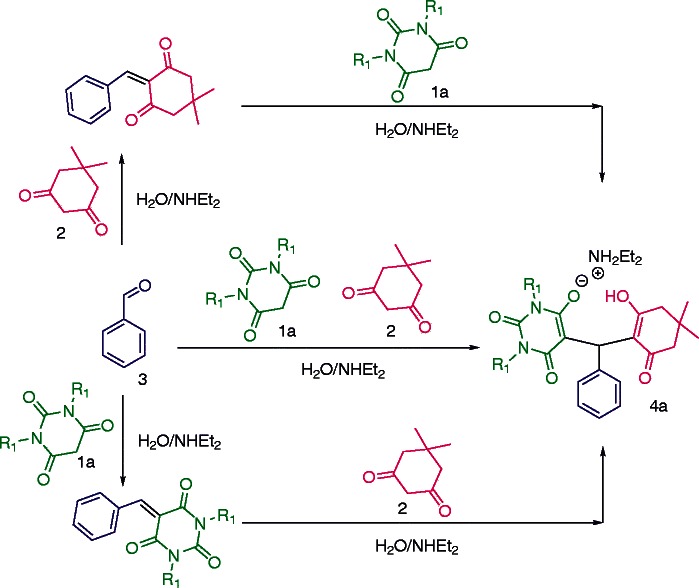
Synthesis of 4a.